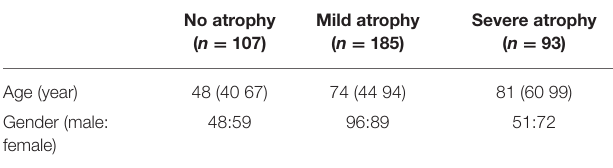
TABLE 1 | Demographic information of the study